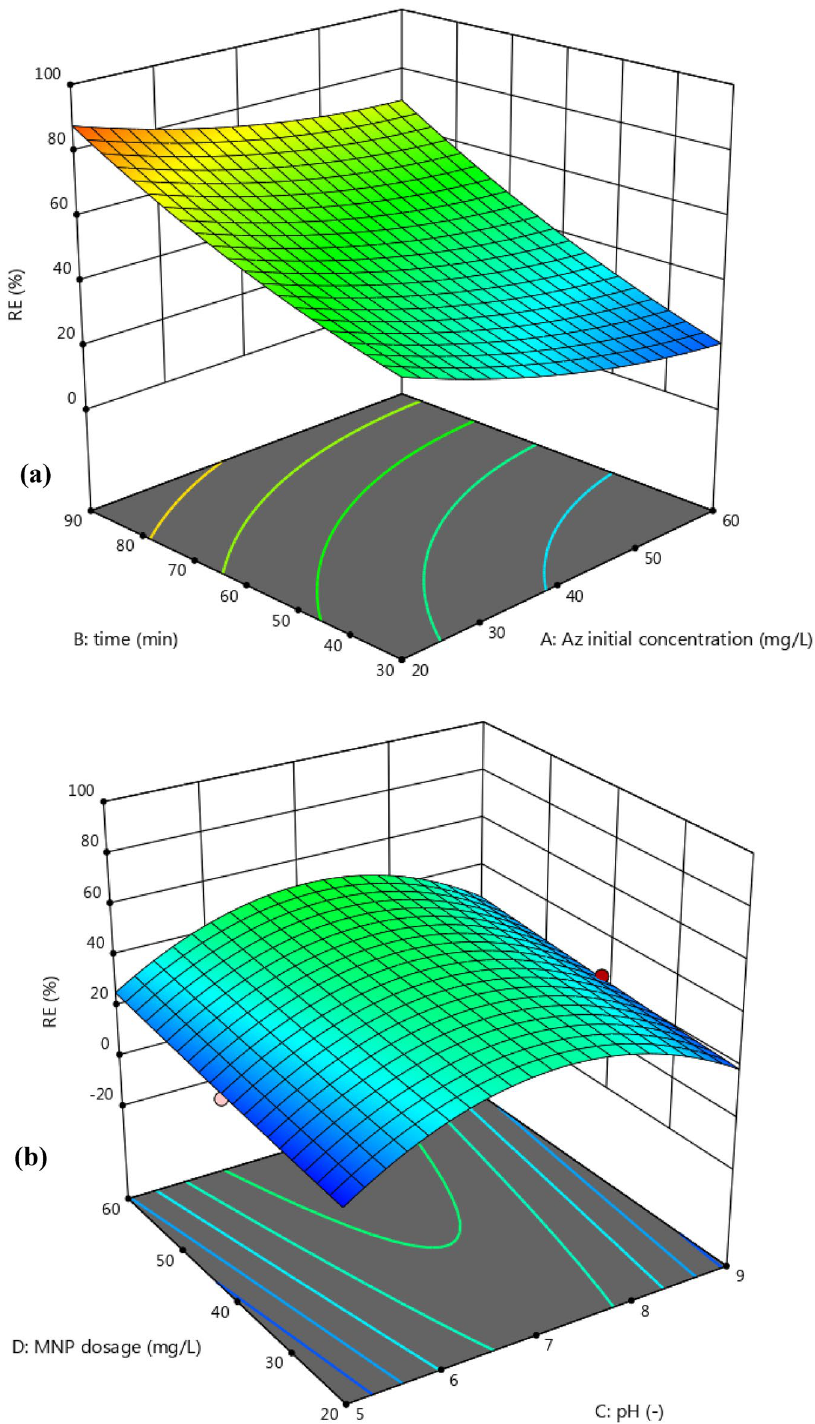
Figure 6. Effect of parameters ( a ) time and Az initial concentration, ( b ) MNP dosage and pH value, on removal